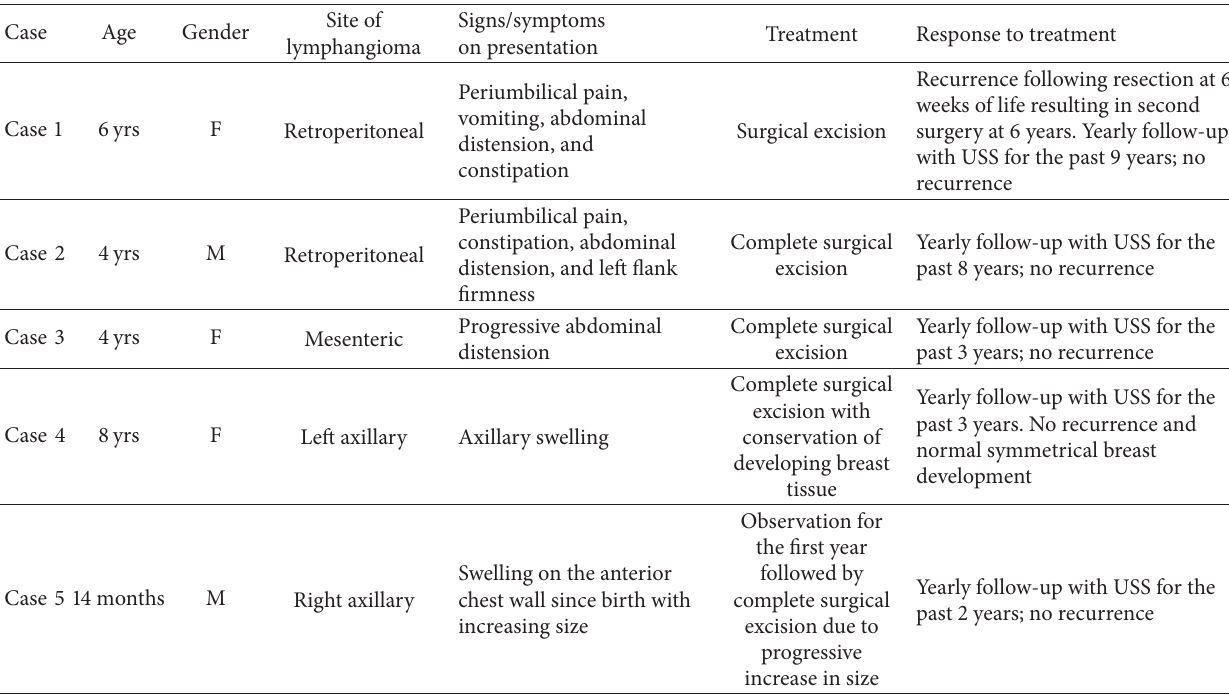
Table 1: Comparison of cases.